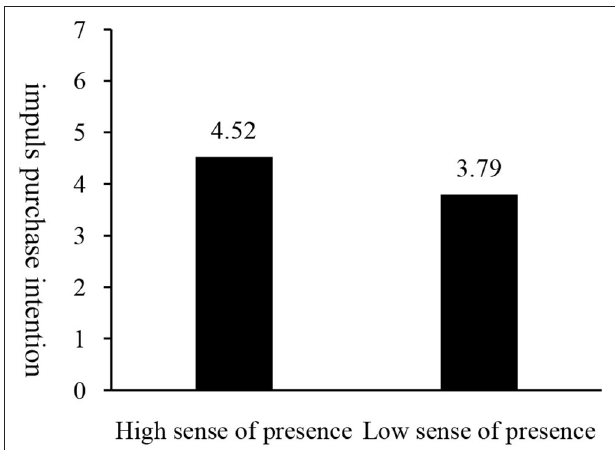
FIGURE 7 | Impact of co-presence on impulse purchase